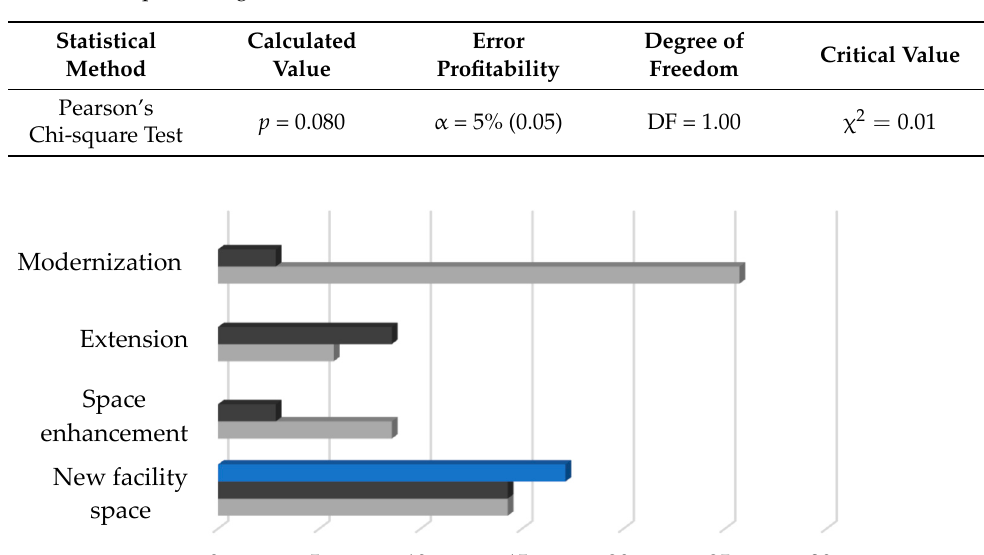
Table 4. The results of testing 3 hypothesis using the Pearson's Chi-square test of independence.